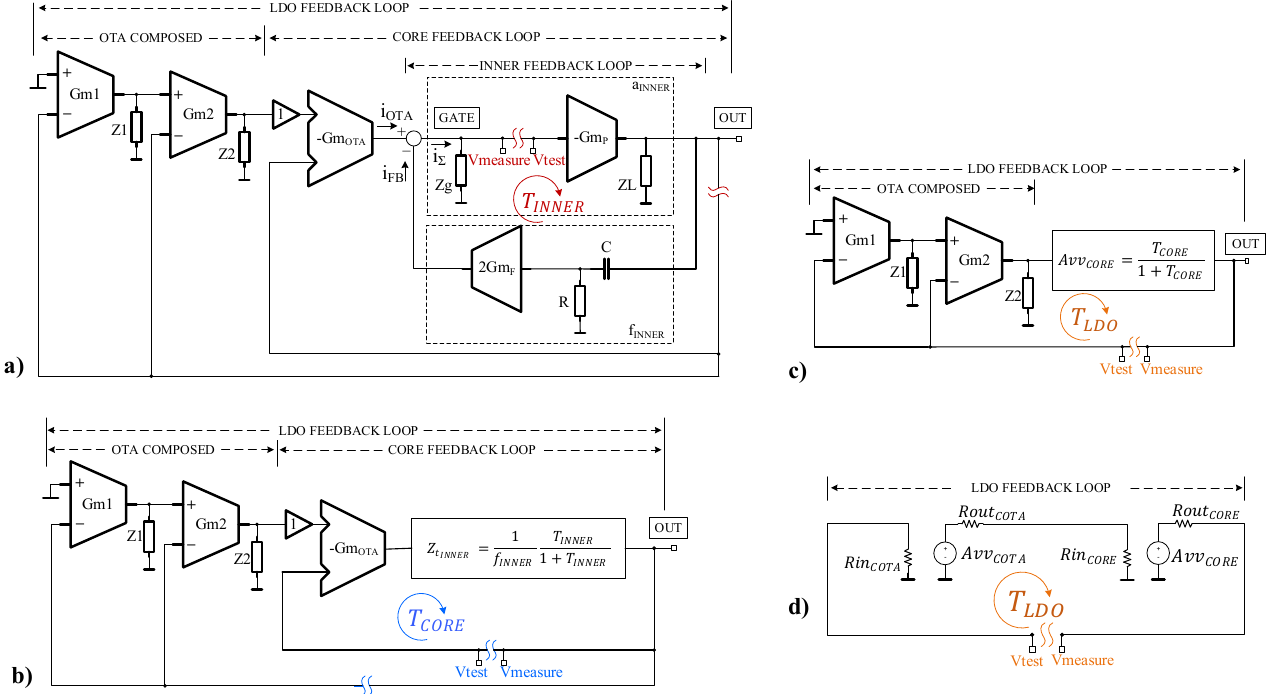
Figure 4. Small signal diagram of the LDO showing simplified representations of the small-signal model for computing T INNER ( a ), T CORE ( b ), and T LDO ( c , d ) feedback loops. After each step, the resulting loop gain is replaced by its equivalent circuit, derived by using classical feedback theory. T INNER has the same expression as its loop gain with the same name in [10]. The detailed analysis presented there yielded two main design constraints for the R and C comprising the frequency compensation network, valid here, as well: